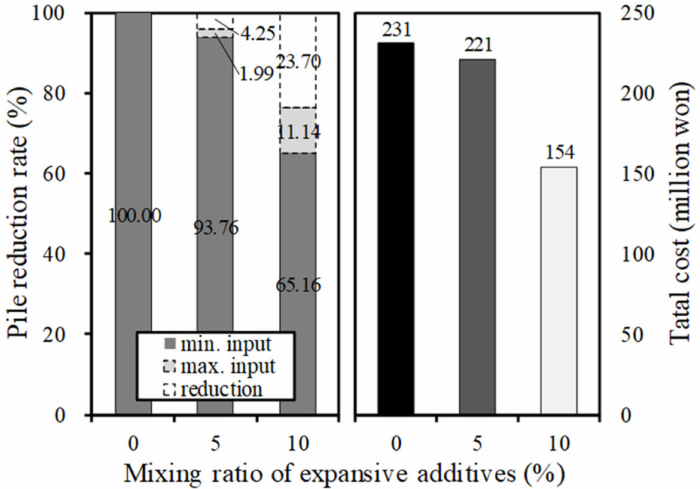
Figure 8. Pile reduction percentage and construction cost projections based on the mixing ratio of expansive